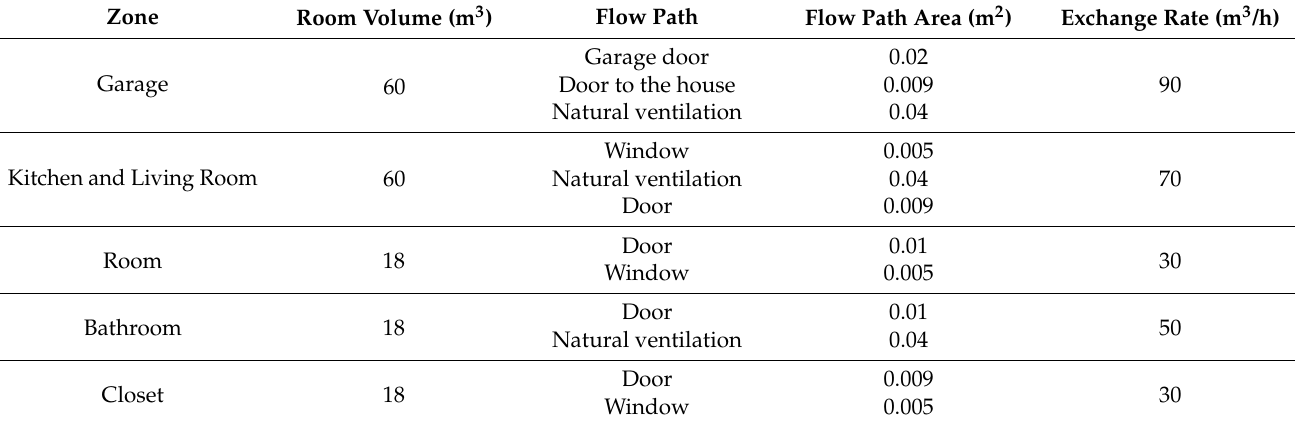
Table 2. Zone and flow path